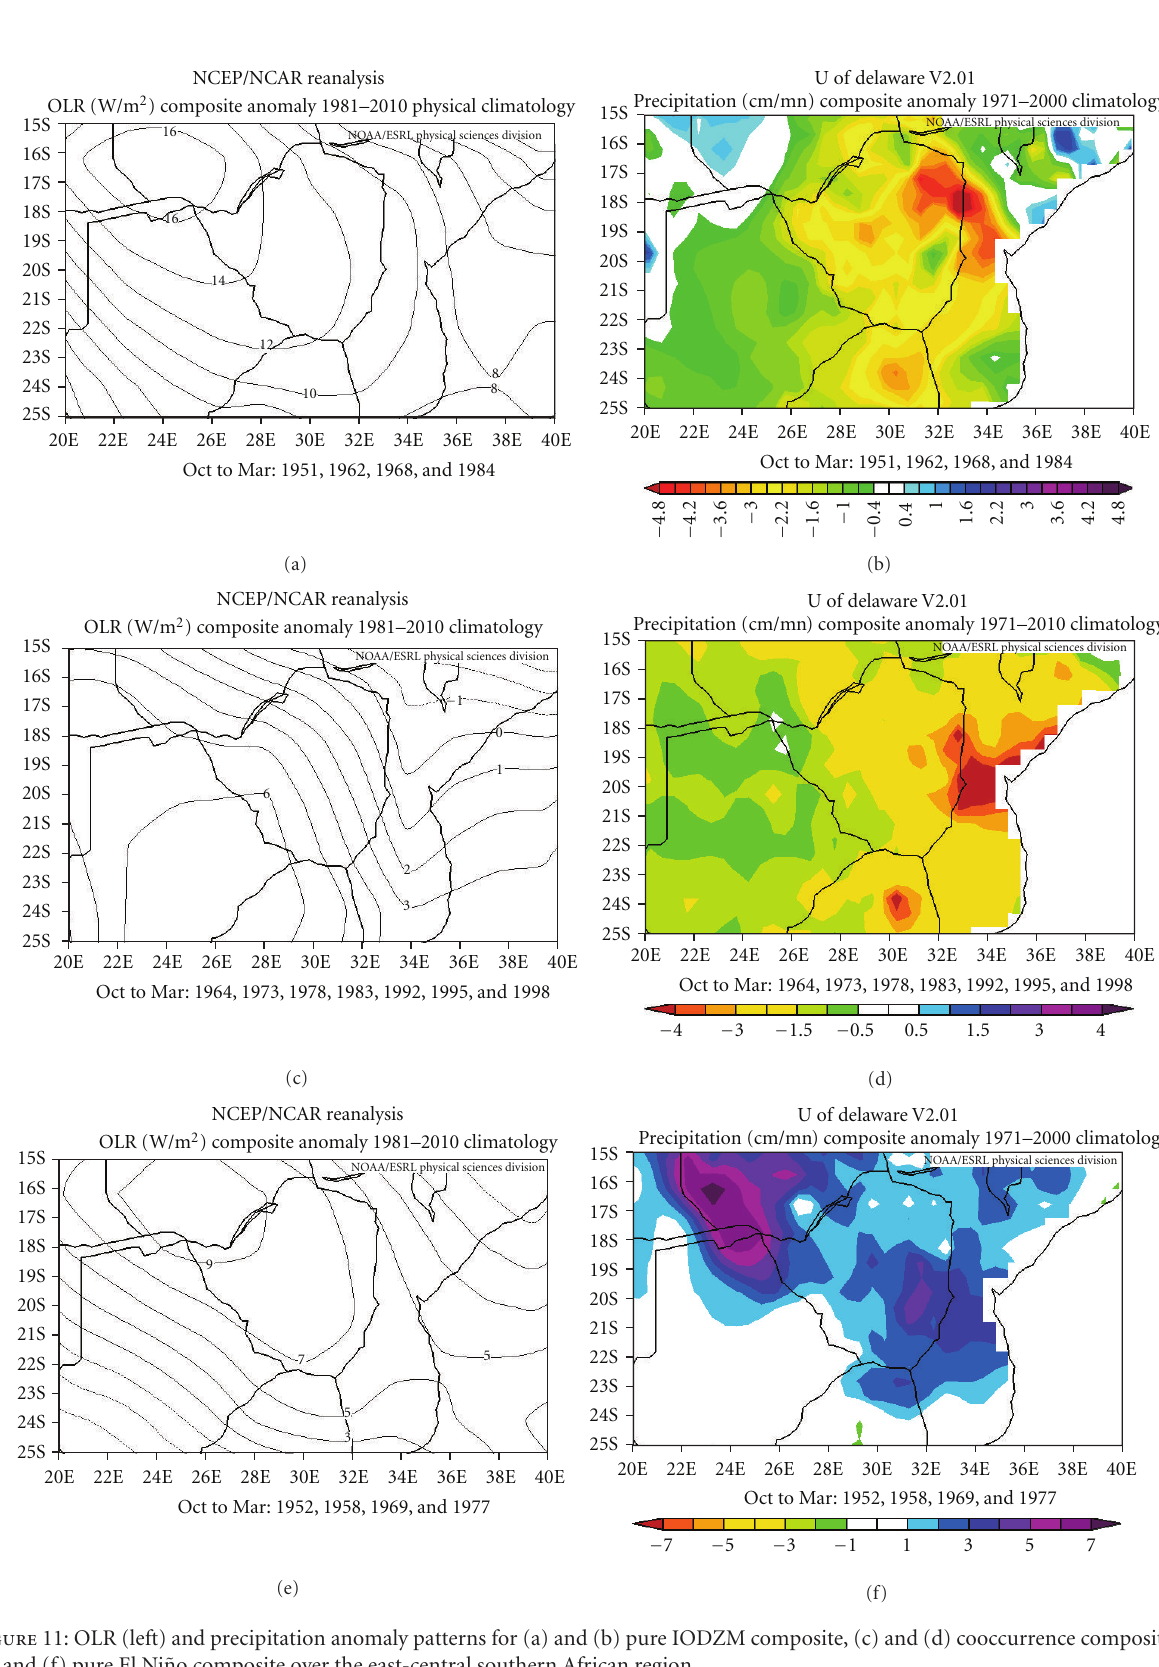
Figure 11: OLR (left) and precipitation anomaly patterns for (a) and (b) pure IODZM composite, (c) and (d) cooccurrence composite, and (e) and (f) pure El Ni˜no composite over the east-central southern African